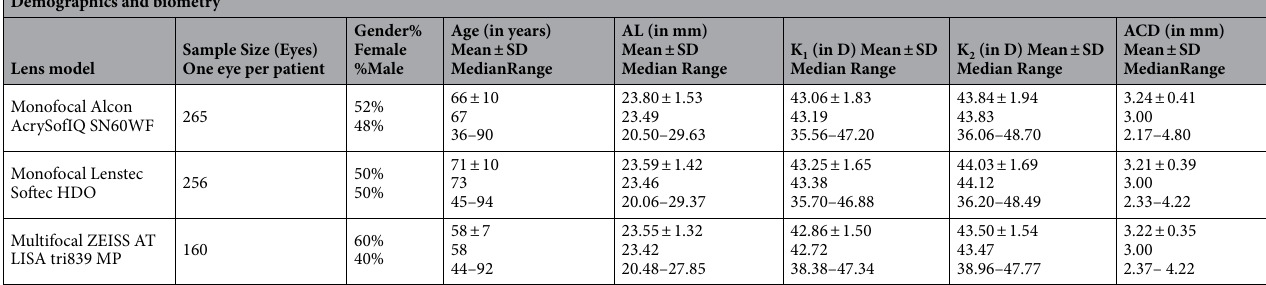
Table 1. Summary of demographics and biometry. AL Axial Length, K 1 Flat Keratometry readings, K 2 Steep Keratometry readings, SD Standard